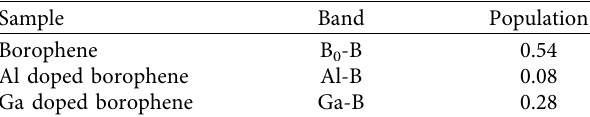
Table 3: Mulliken population analysis of bands around the im- purity